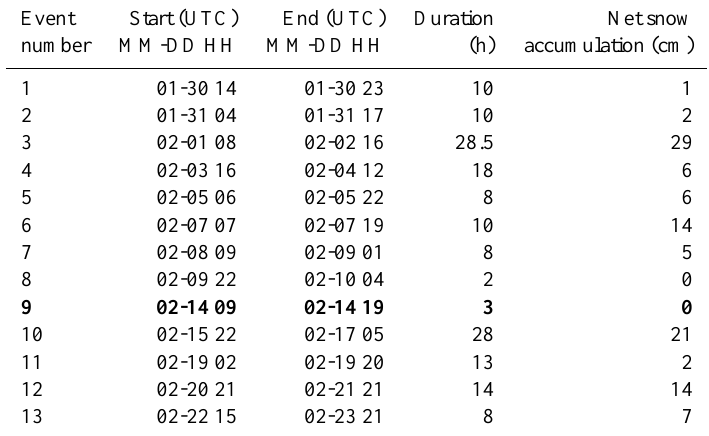
Table 1. List of the 13 precipitation events identified by means of radar data during CLACE 2014. The net duration of the events includes only time intervals during which precipitation was observed at the lowest available radar resolution volume, while the net snow accumulation is obtained from the MeteoSwiss MAE station (see Fig. 1). Bold is used to highlight one event during which the radar was significantly affected by technical